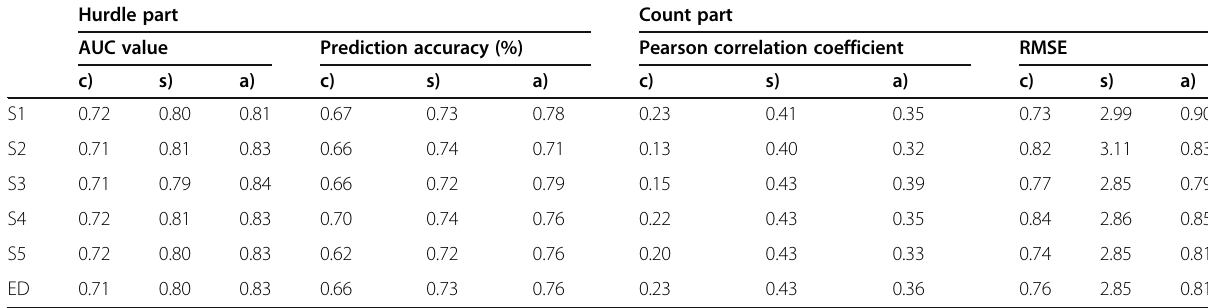
Table 4 Performances of the Negative Binomial Hurdle models (hurdle and count parts) evaluated for the three study regions and each of the five subsamples Hurdle part Count part AUC value Prediction accuracy (%) Pearson correlation